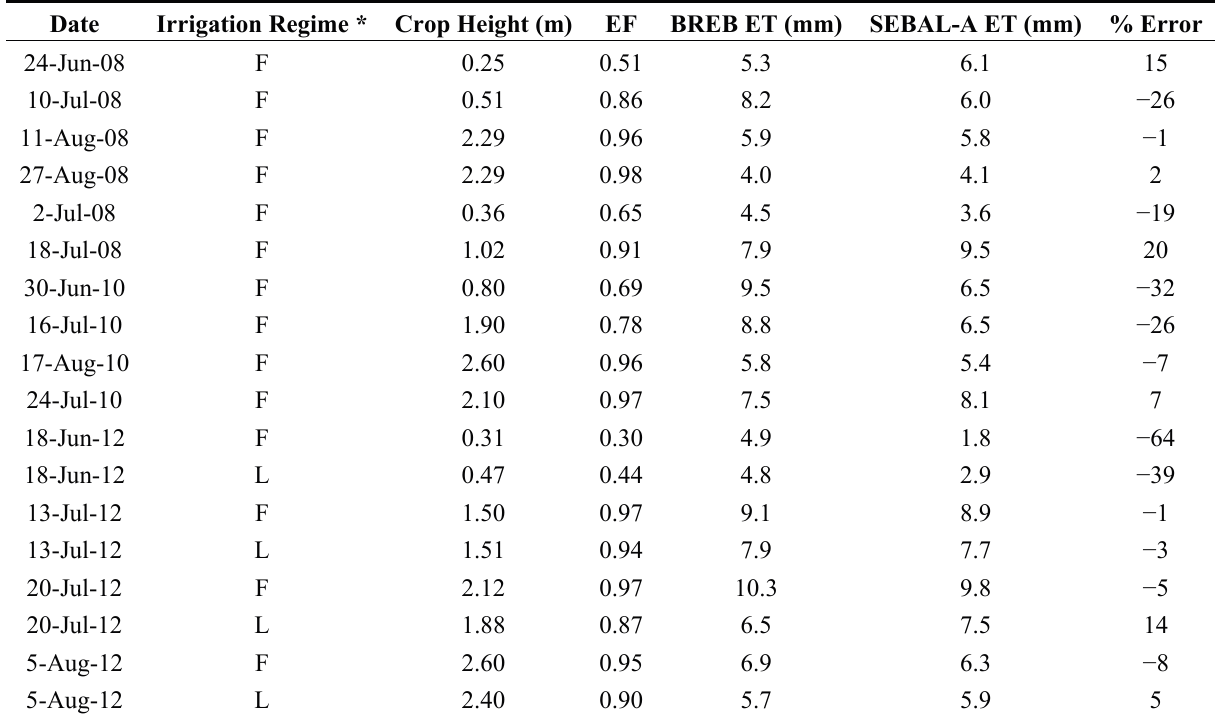
Figure 2. Original SEBAL crop ET compared to measured-ET for corn (from limited and fully irrigated fields). Table 2. Comparison of SEBAL-A estimated corn ET with BREB ET measured at the USDA ARS LIRF